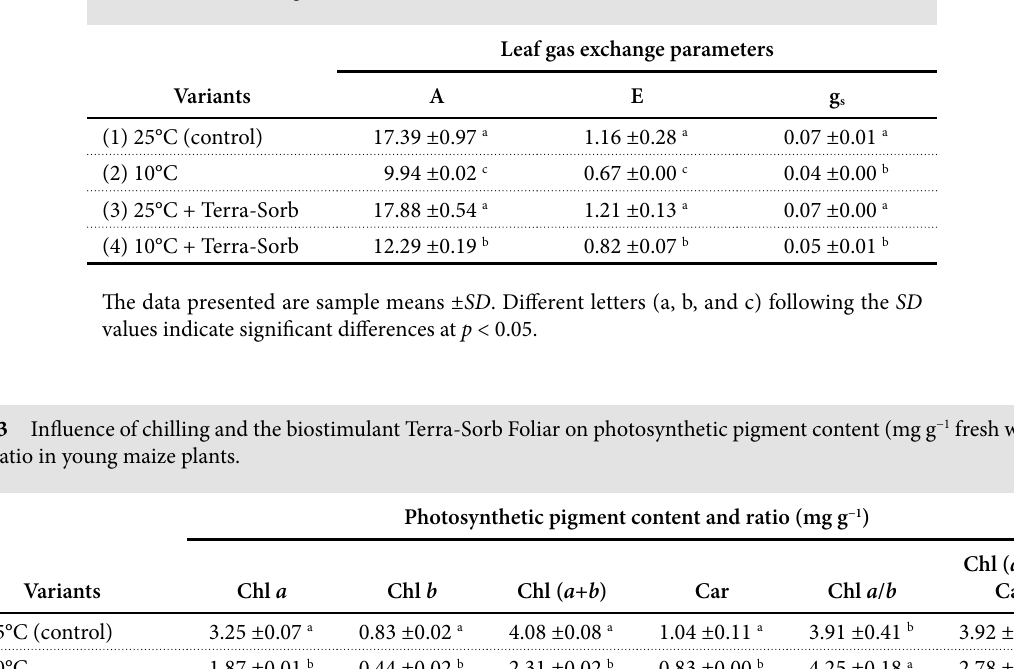
Tab. 2 Influence of chilling and the biostimulant Terra-Sorb Foliar on leaf gas exchange